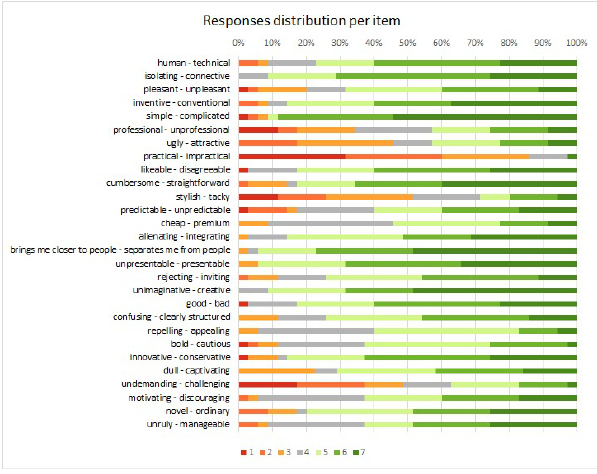
Figure 12. AttrakDiff Results ­ Remote Virtual Interaction.